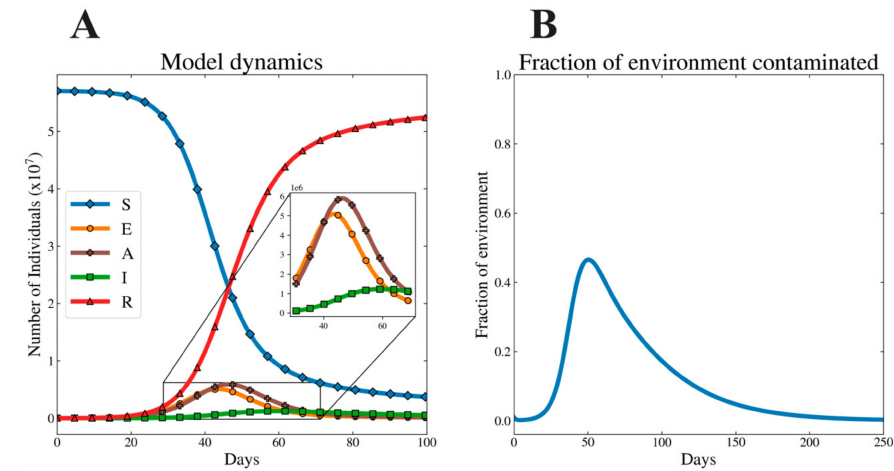
Figure 3. Sample dynamics for the model system: ( A ) the dynamics for all host compartments within the model and ( B ) the fraction of environmental reservoirs in a setting that are contaminated with infectious